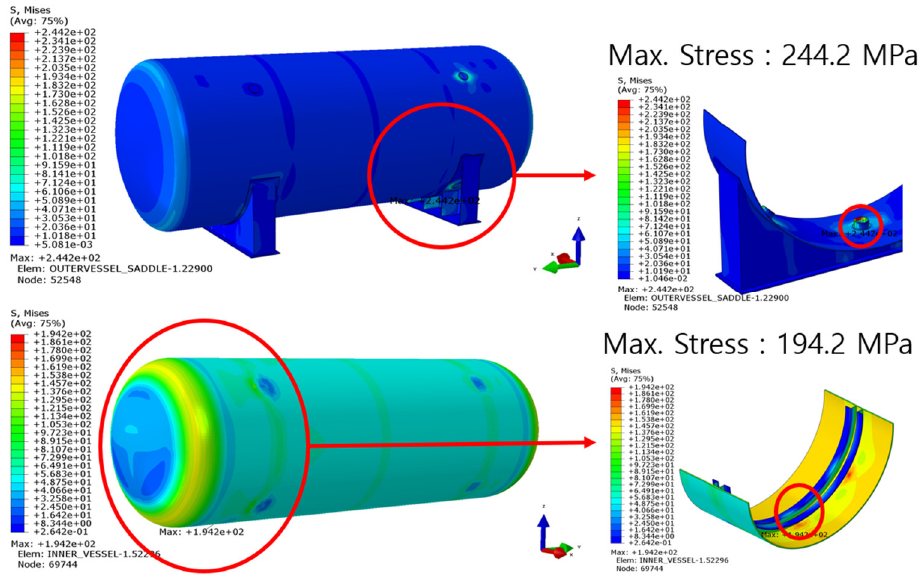
Figure 14. Stress contour of strength evaluation in transverse acceleration (AL-5083-O). Table 7. Summary of structural analysis results.